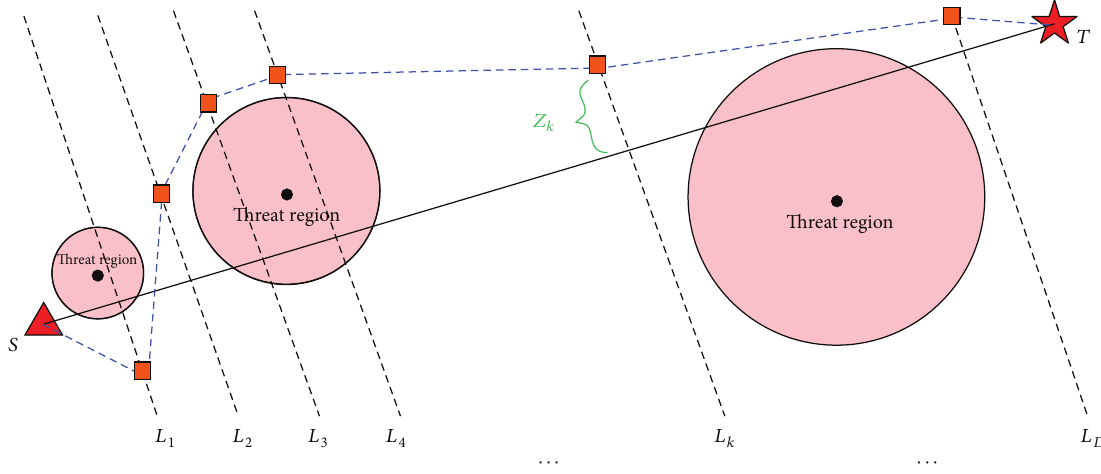
Figure 1: Schematic diagram of combat field modeling.